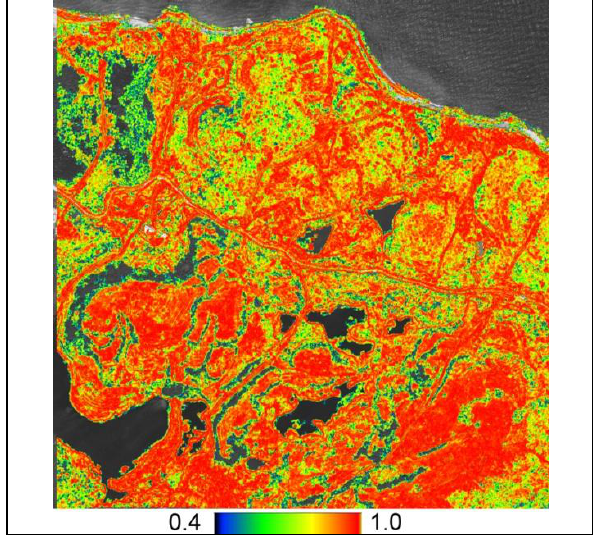
Fig. 9 : color coded size of correlation coefficients in a sub-area matched with 0.5m GSD images, correlation threshold =0.4, in grey = used image for matching in the not accepted area With a threshold for the correlation coefficient of 0.4 (figure 9) instead of 0.6 (figure 8) the forest areas are quite better covered by accepted points. Nevertheless for the project the height of the bare ground was required and this is not possible by matching in closed forest areas. Even by filtering in forest areas the ground height cannot be achieved if no point is located on the ground.